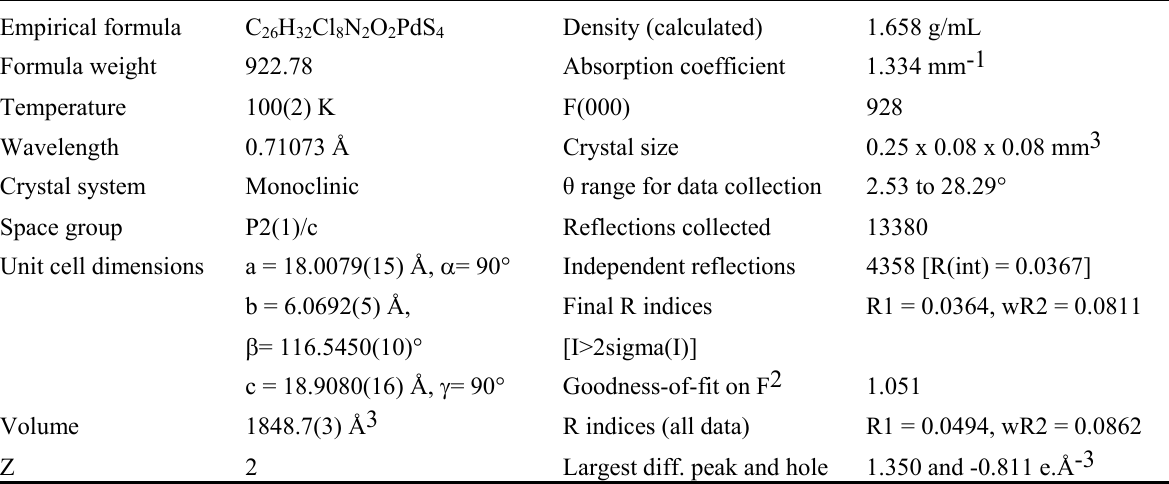
Table 2. Crystal data and structure refinement